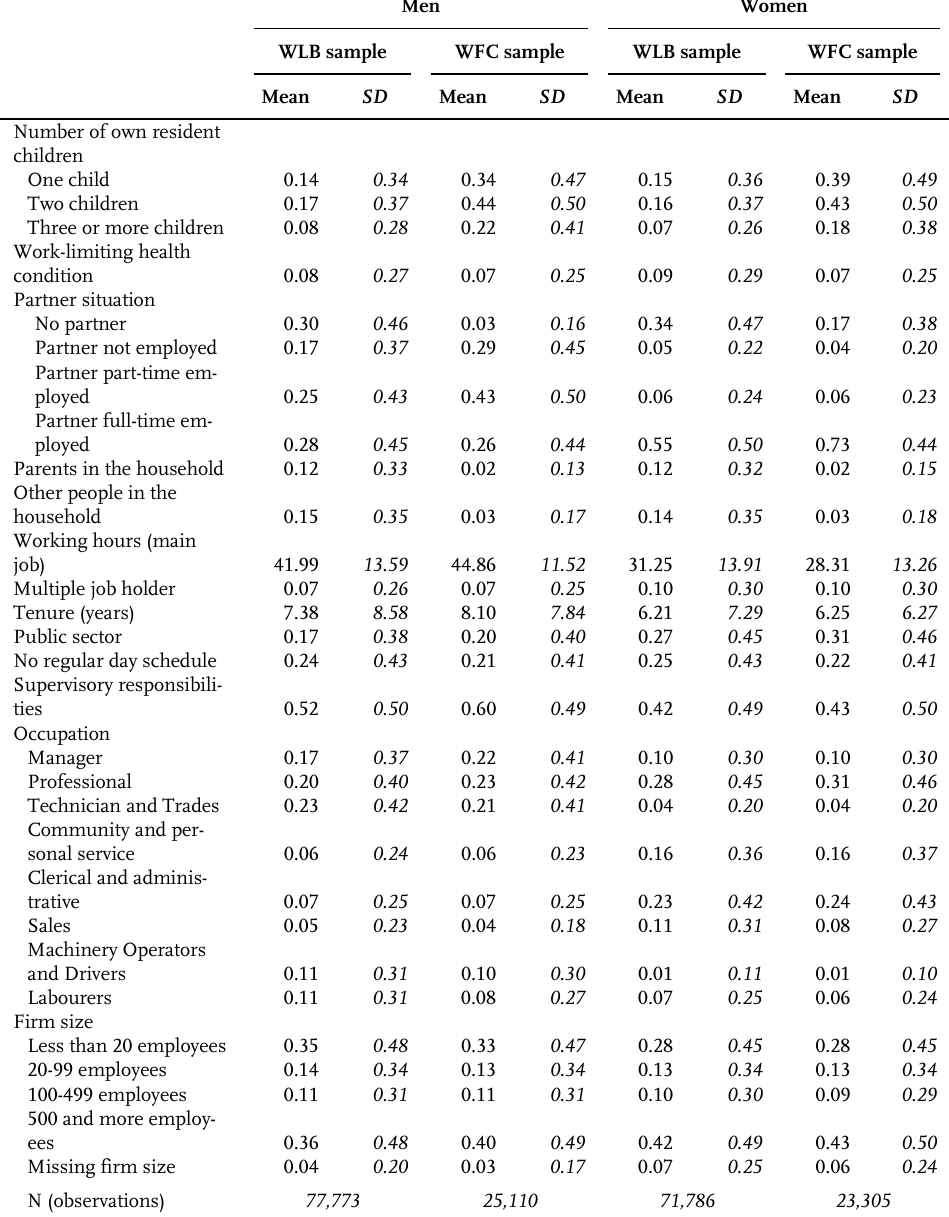
Table 1 : Summary statistics for analysis samples